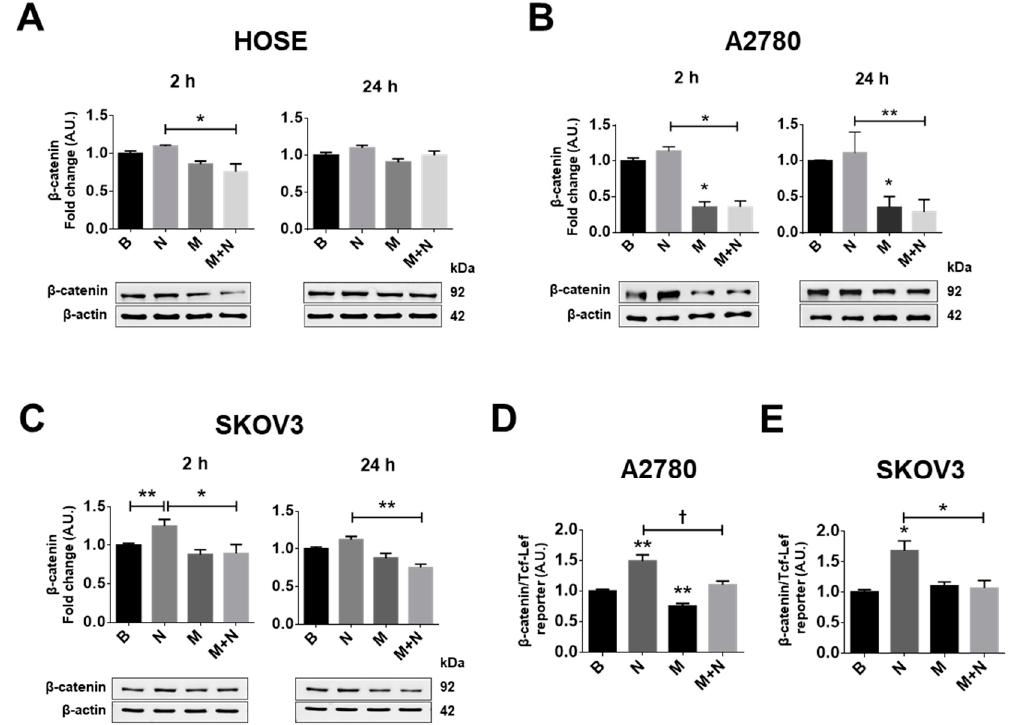
Figure 2. Metformin decreases the NGF-induced β -catenin / TCF-Lef transcriptional activity in EOC cells. Ovarian cells were treated with metformin 10 mM for 48 h and / or NGF 100 ng / mL or 150 ng / mL (A2780 / HOSE cells and SKOV3 cells, respectively) for 24 h or the last 2 h. ( A – C ) Western blots of β -catenin in HOSE, A2780 and SKOV3 cells after the respective treatments. ( D , E ) Gene reporter assays to evaluate β -catenin / TCF-Lef transcriptional activity in the EOC cells A2780 and SKOV3. N = 4 independent experiments. * p < 0.05 and ** p < 0.01. Statistical analysis: Kruskal–Wallis test and Dunn’s post-test. † p < 0.05 as indicated according Mann–Whitney test. B: basal condition (without stimuli), N: NGF, M: metformin treatment. Results are expressed as the mean ± standard error of the mean (SEM).